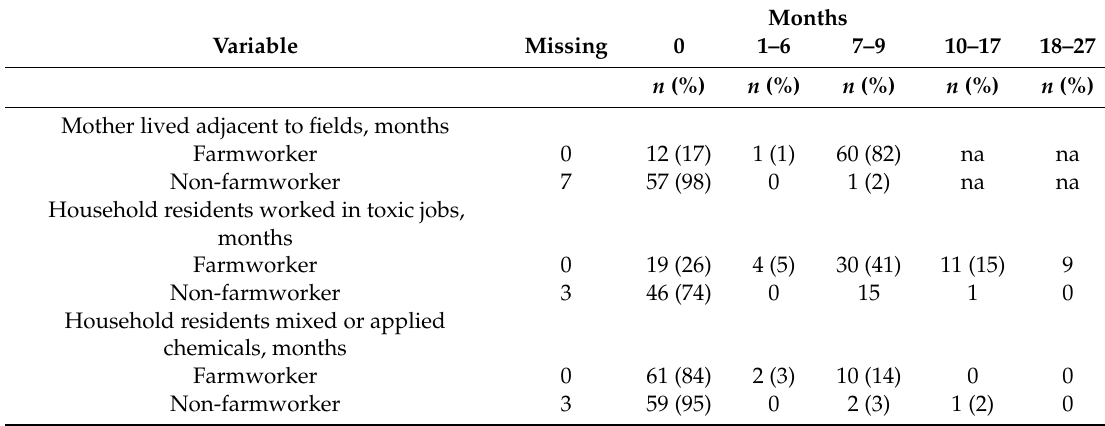
Table 1. In utero exposure to pesticides and other toxic chemicals, comparing number and percent